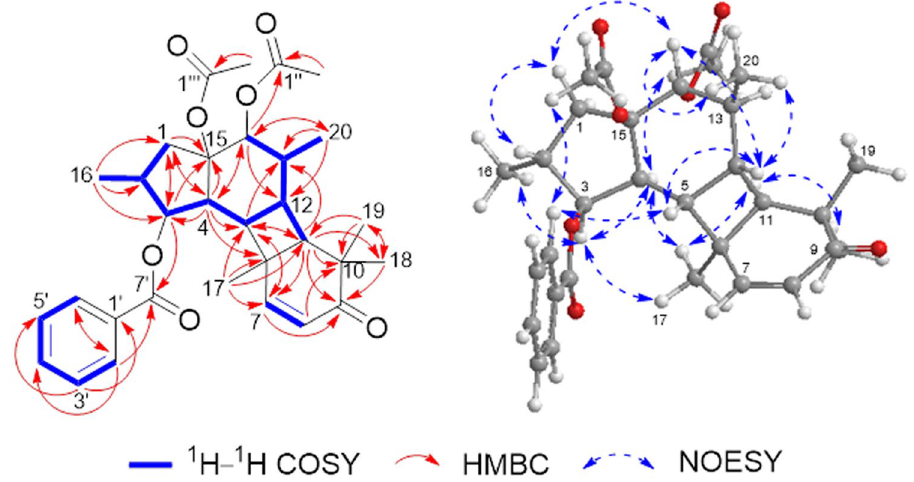
Figure 2. Key 1 H– 1 H COSY, HMBC and NOESY correlations for 1.